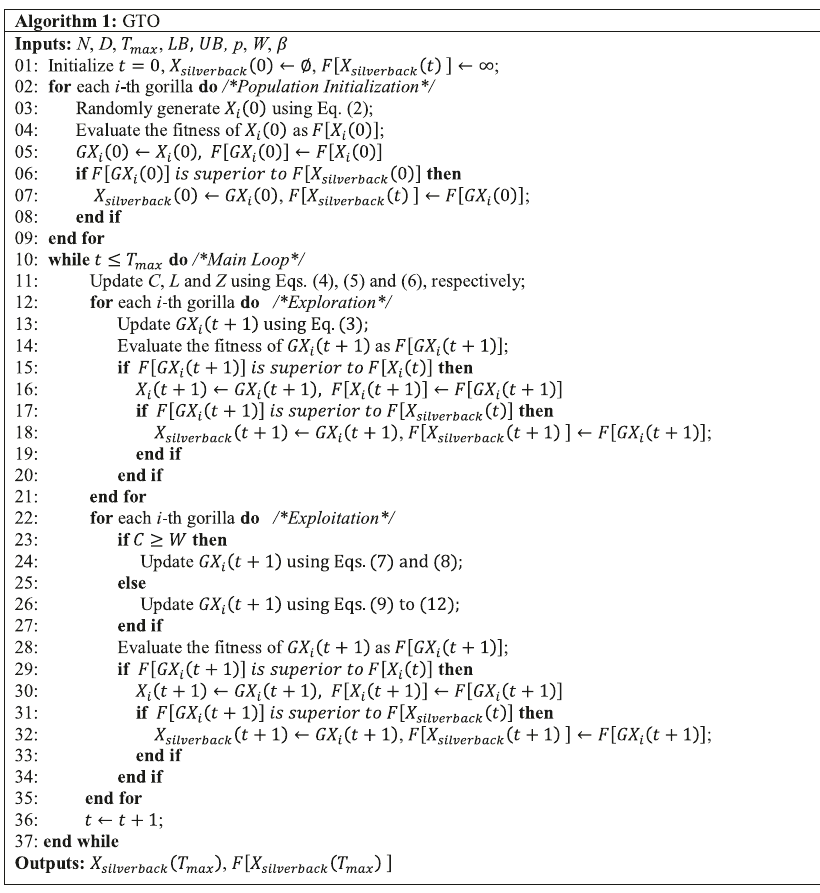
Figure 2: Pseudocode of